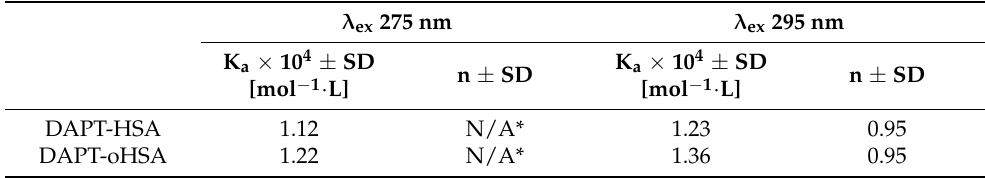
Figure 9. The Stern-Volmer curves of F 0 /F vs. 10 H -3,6-diazophenothiazine (DAPT) concentration at ( a ) λ ex 275 nm and ( b ) λ ex 295 nm; the error calculated as maximum deviation does not exceed the symbols. Table 5. Binding parameters for DAPT-HSA and DAPT-oHSA systems at λ ex 275 nm and λ ex 295